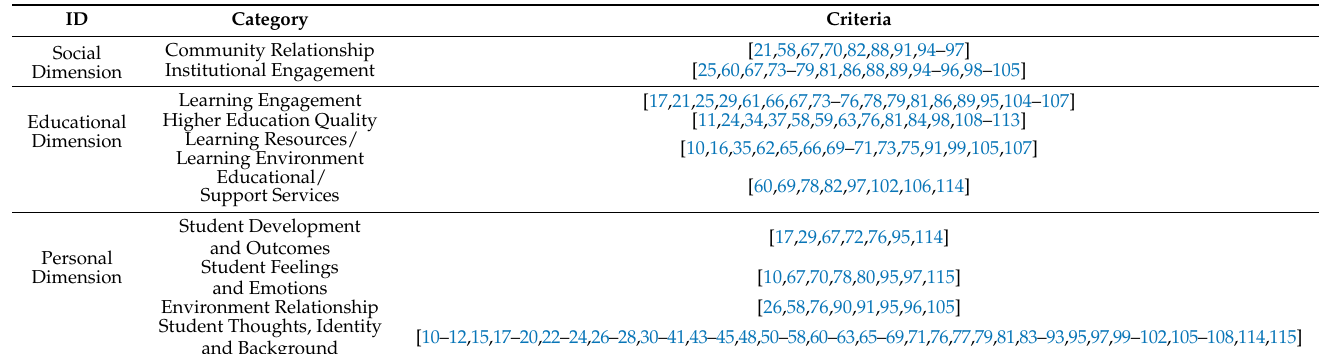
Table 5. Student experience observable